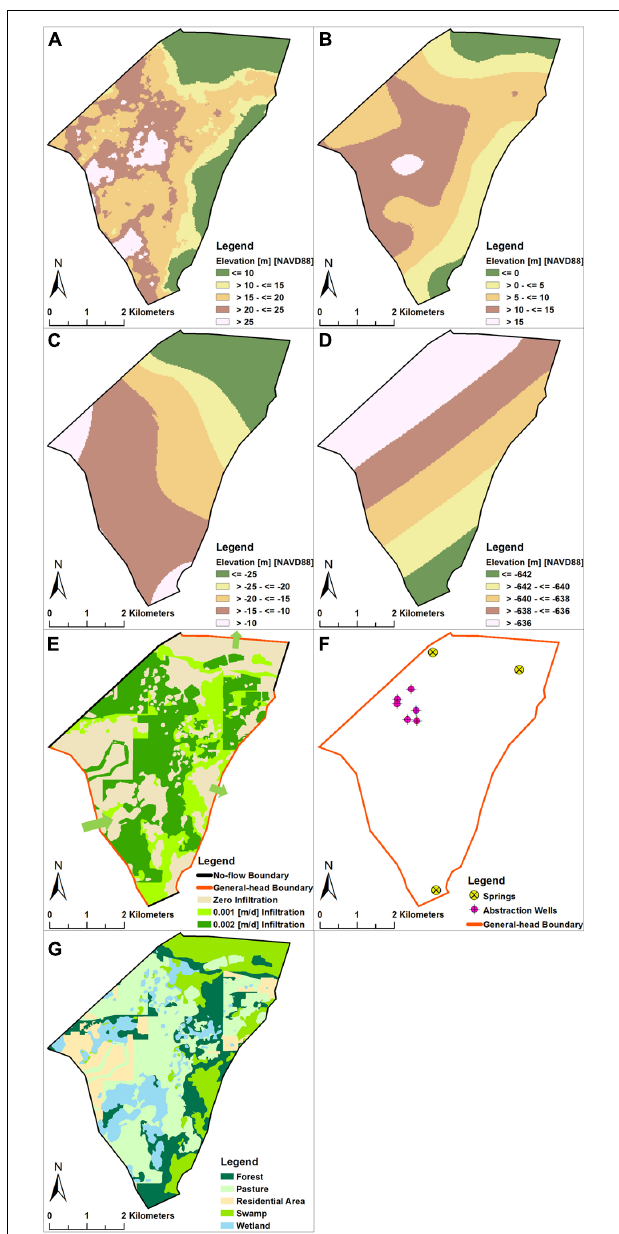
FIGURE 2 | (A) Top elevations of Layer 1 (modified after US Geological Survey National Elevation Dataset); (B) top elevations of Layer 2 (modified after Williams and Kuniansky, 2016); (C) top elevations of Layer 3 (modified after Williams and Kuniansky, 2016); (D) bottom elevations of Layer 3 (modified after Williams and Kuniansky, 2016); (E) boundary conditions assigned to Layer 1; (F) boundary conditions assigned to Layer 3; (G) map of land use and land cover (modified from the GIS database maintained by St. Johns River Water Management